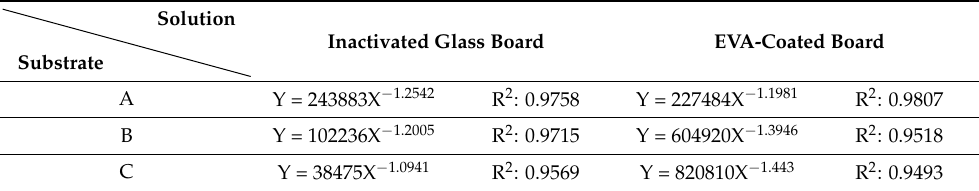
Table 1. Nonlinear regression analysis of film thickness on inactivated glass board and EVA-coated board. X: spin speed in rpm. Y: film thickness in micrometer.